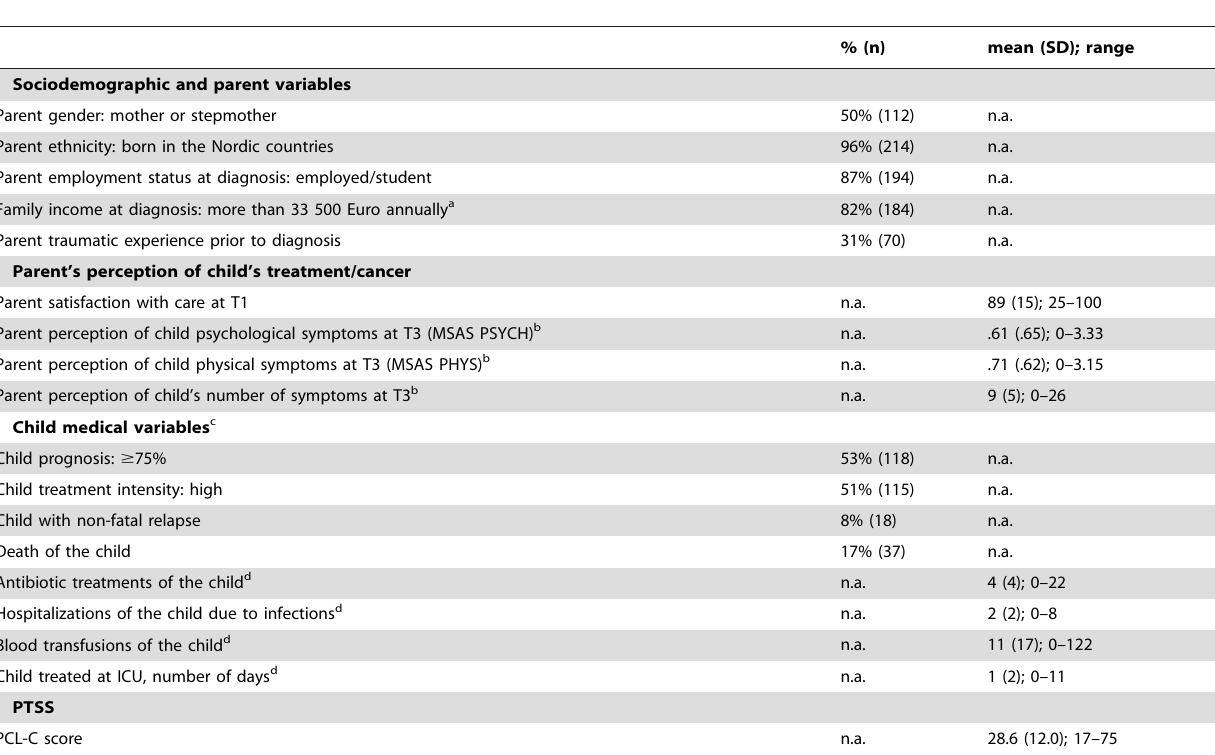
Table 2. Descriptive statistics for the independent and dependent variables